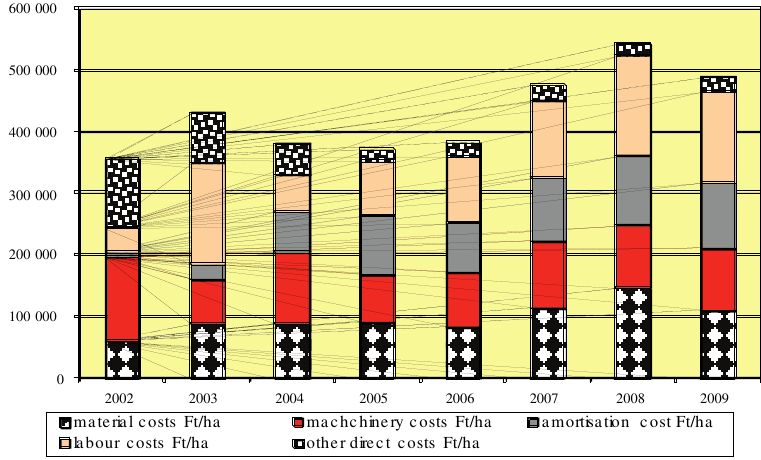
Figure 1. Constituents of direct costs of sour cherry production as means of relevant commercial plantations in Hungary Source: AKI and original calculations